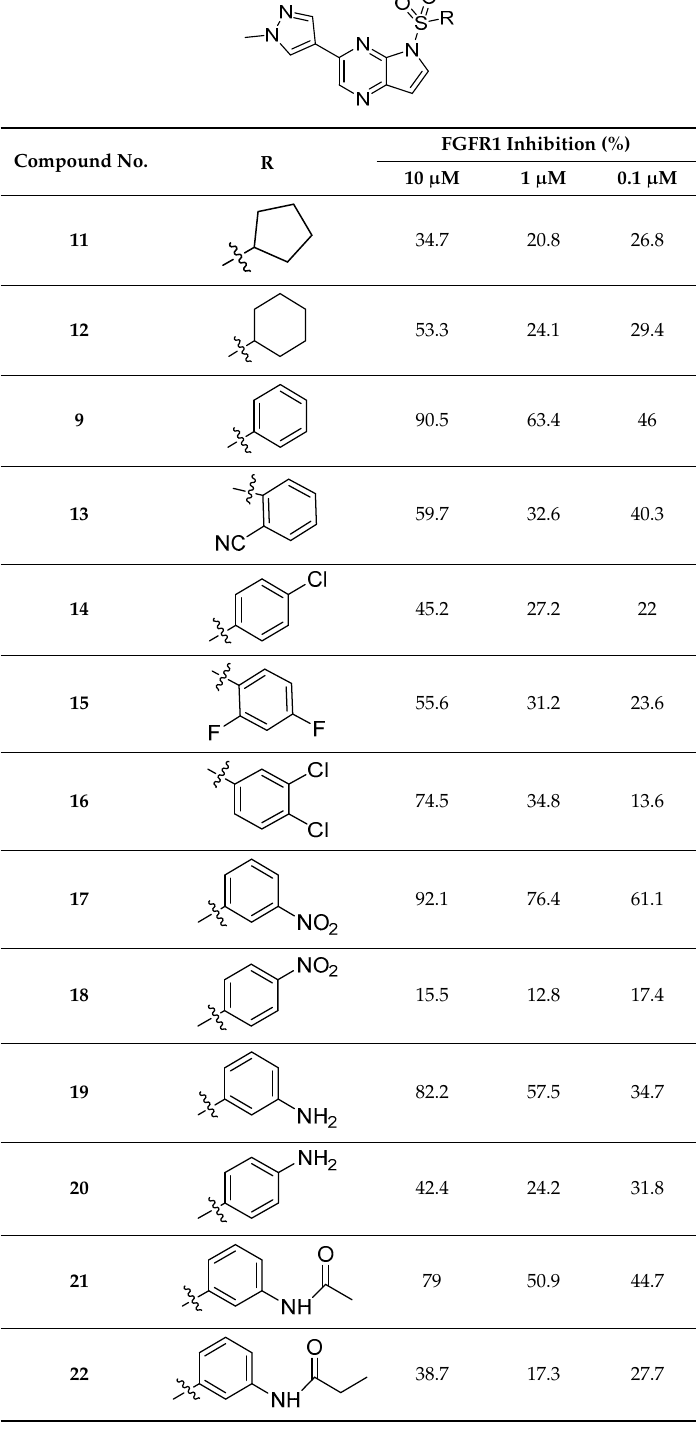
Table 3. Structures and FGFR1 enzymatic activities of compounds 11 – 22 .